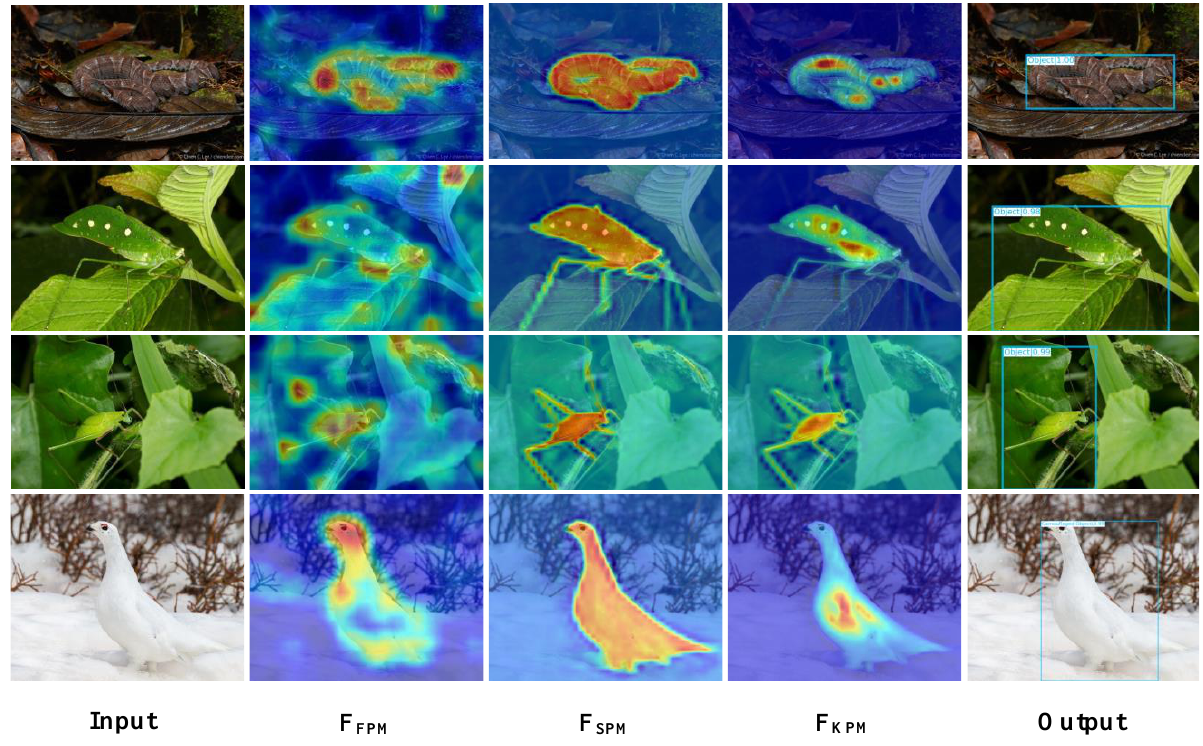
Figure 11. Visual comparison results of the ablation experiment.